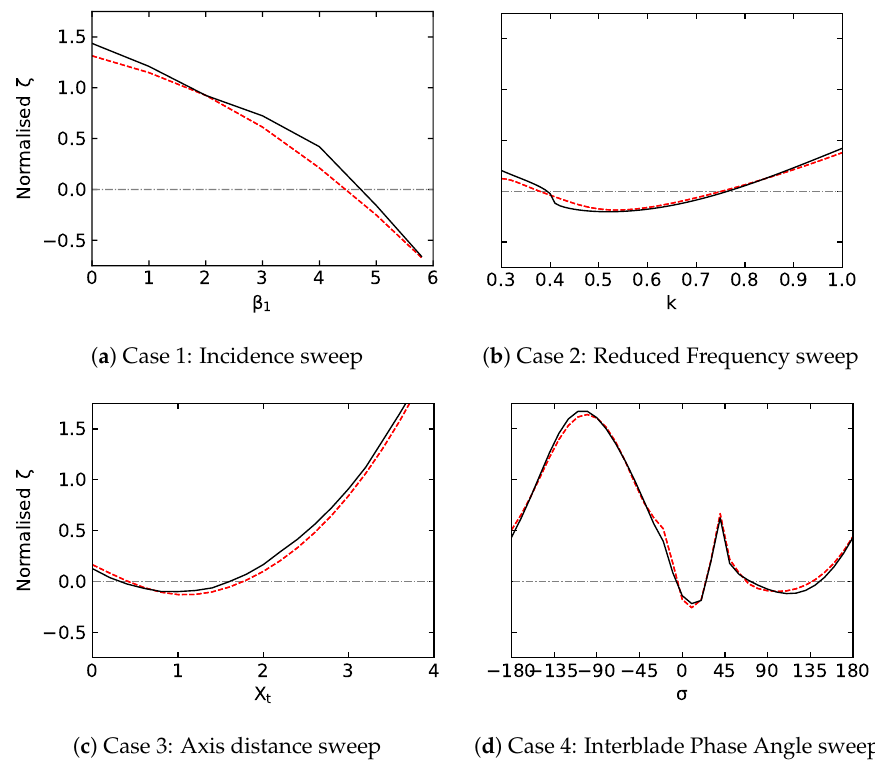
Figure 7. Comparison of ANN (dashed red line) and CFD (solid black line)